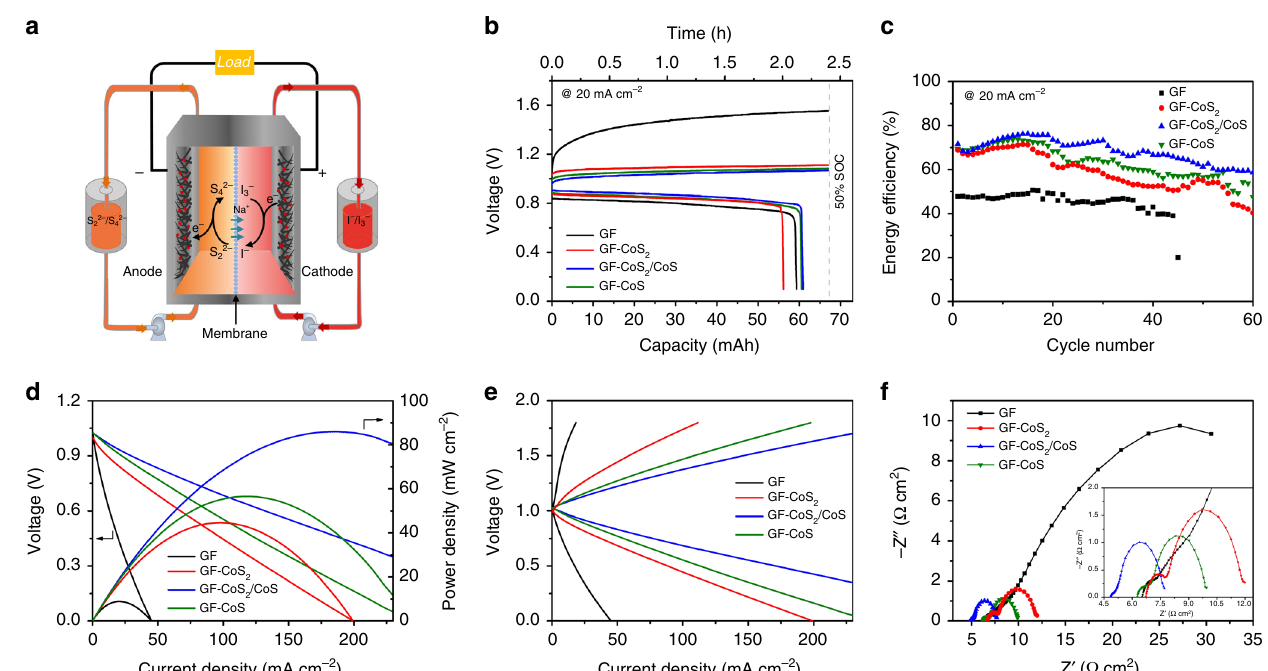
Fig. 5 Con fi guration and performance of the polysul fi de/iodide redox fl ow batteries (SIFBs). a Scheme of the proposed SIFB cell con fi guration. b The fi rst charge and discharge curves of SIFBs based on graphite felt (GF), GF-CoS 2 , GF-CoS 2 /CoS, and GF-CoS electrodes with N115 and N117 as the separator at 20 mA cm − 2 with the 50% state of charge (SOC). c The galvanostatic cycling energy ef fi ciency of the SIFBs at 20 mA cm − 2 . d The discharge polarization and power density curves of the SIFBs at 50% SOC. e The polarization curves of both charge and discharge with the same fl ow cell at 50% SOC. f The electrochemical impedance spectroscopic (EIS) plots of SIFBs with GF, GF-CoS 2 , GF-CoS 2 /CoS, and GF-CoS electrodes in the frequency range of 100 kHz to 100 mHz with 5 mV ac oscillation